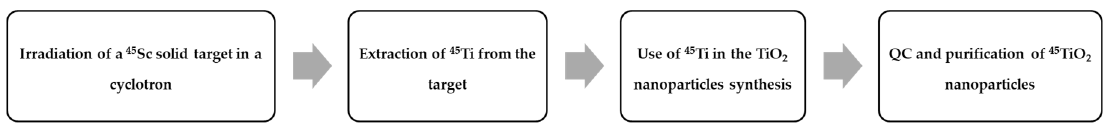
Figure 4. Possible approach to obtain 45 TiO 2 nanoparticles using the cyclotron irradiation of a solid target of 45 Sc.